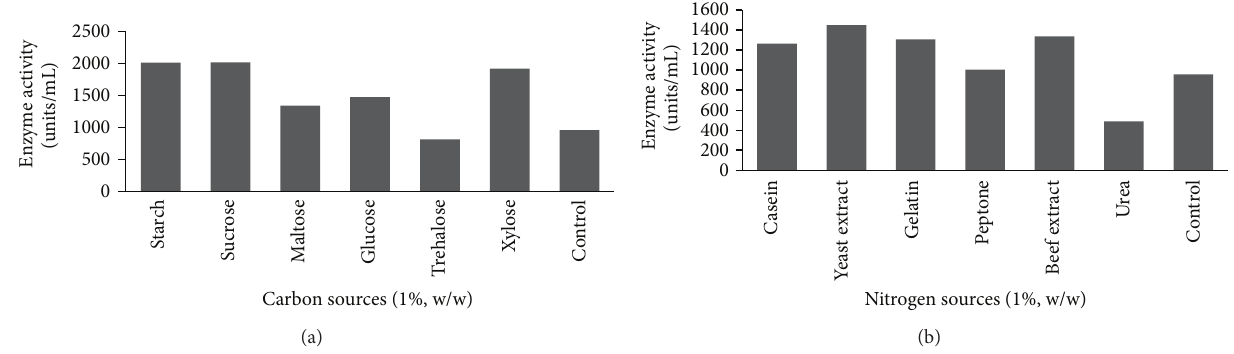
Figure 2: (a) Effect of different carbon sources on production of fibrinolytic enzymes. (b) Effect of different nitrogen sources on production of fibrinolytic